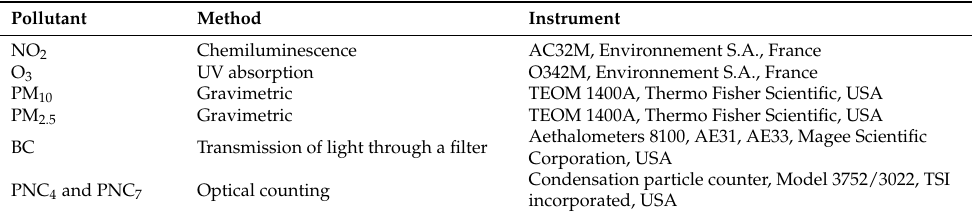
Table A1. Description of the measurement methods and the instruments that have been used to measure the